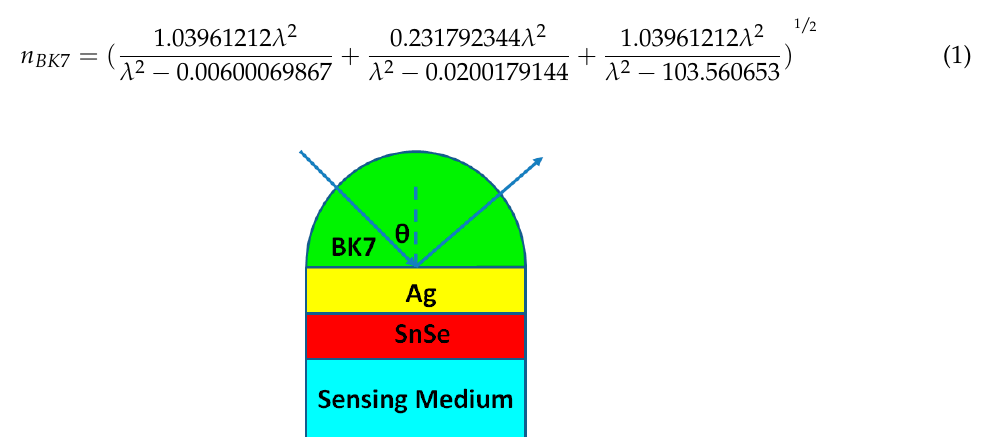
Figure 1. Sketch diagram of the SPR biochemical sensor made using three types of SnSe allotropes to enhance the sensitivity.